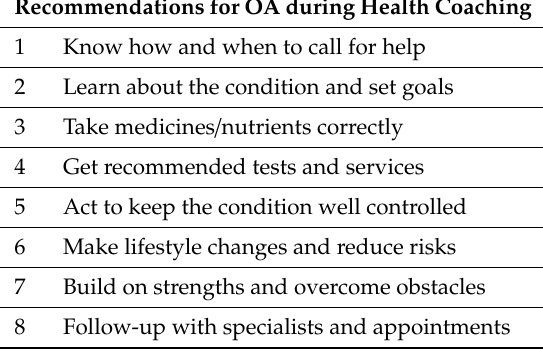
Table 2. Key recommendations for health coaching in